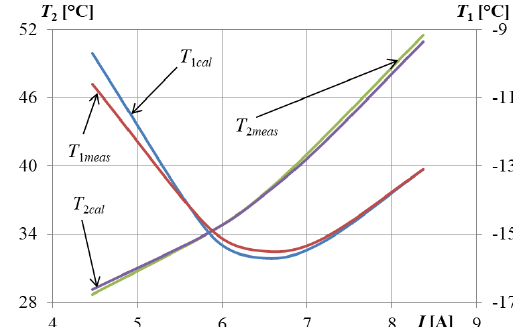
Fig. 4. Comparison of the calculated and measured temperatures T 1 and T 2 on the cold and hot sides of a TEC-127085 type cell .